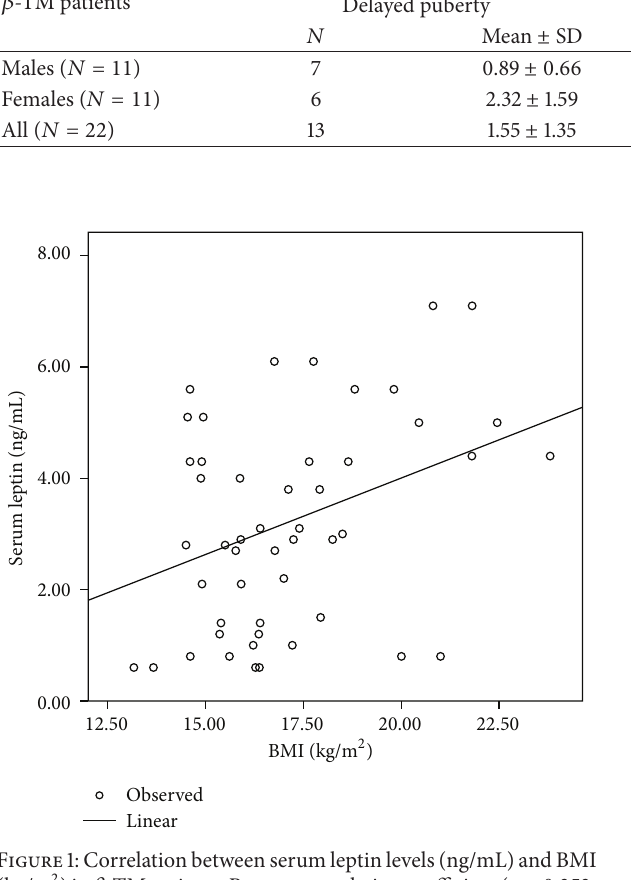
Table 2: Serum leptin levels in patients with 𝛽 -TM with delayed and normal puberty according to gender. 𝛽 -TM patients